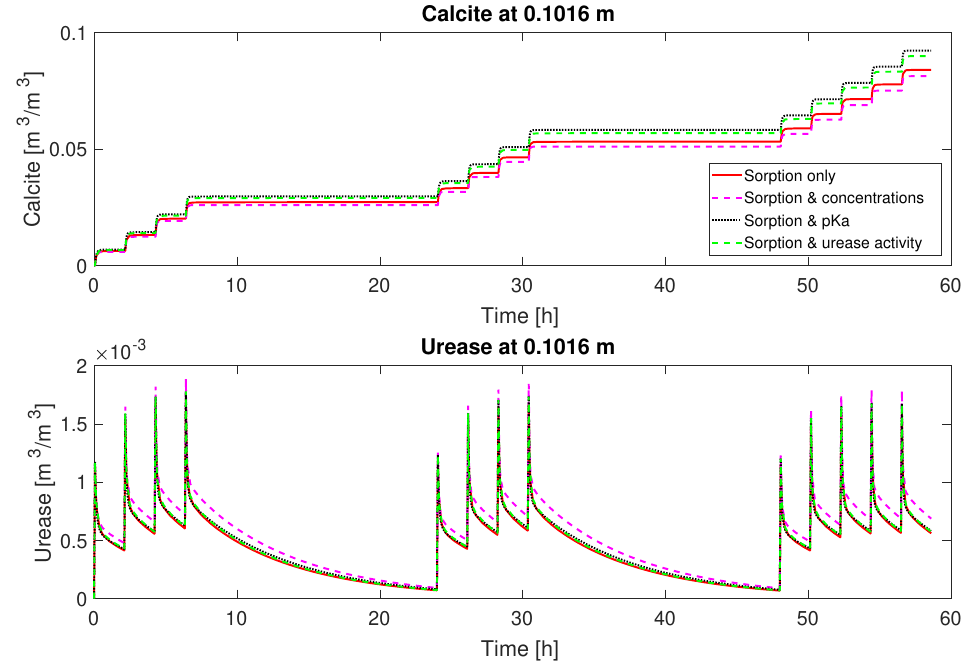
Figure 8. Prediction of concentration measurements at 10.16 cm from the inlet for column experiment #1 (0.33 M mineralization medium